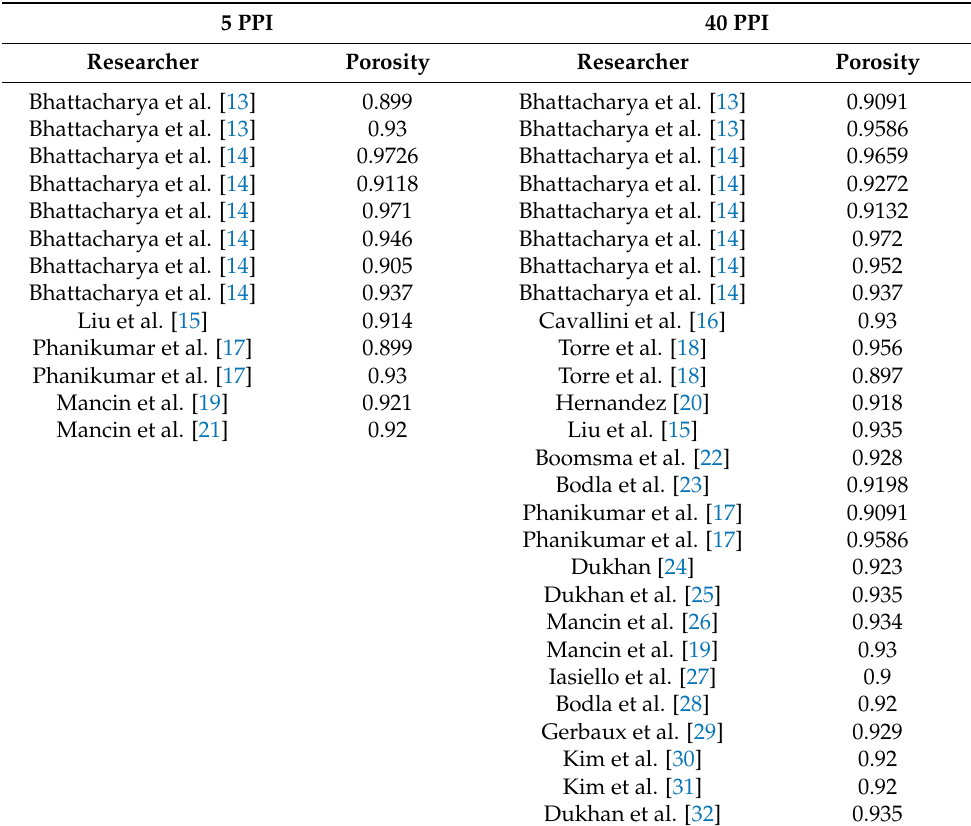
Table 2. The reported studies in literature used to find the average permeability and inertia coefficient of metal foams with 5 and 40 PPI. 5 PPI 40